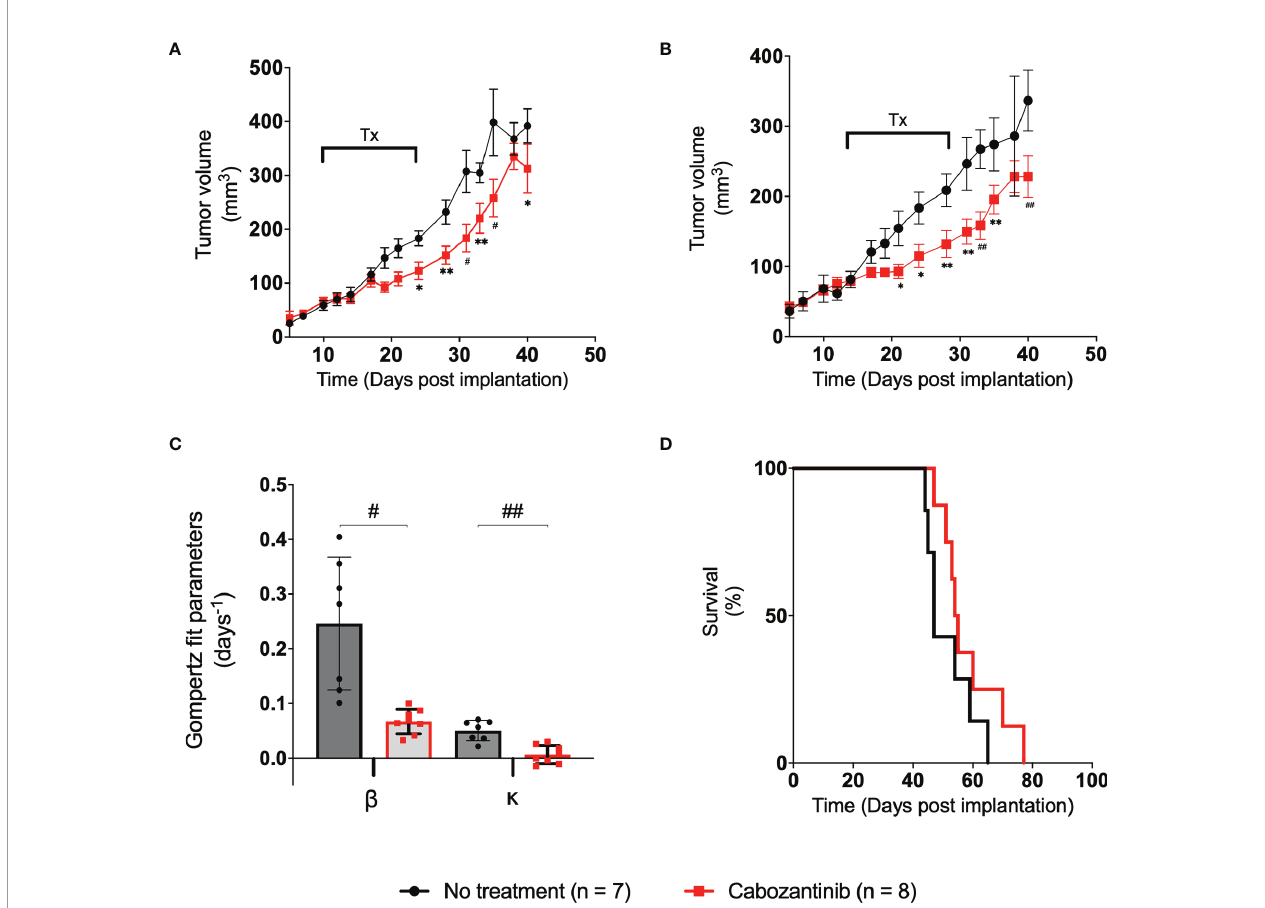
FIGURE 3 | (A) Plot of tumor volume obtained from ultrasound images vs. the time post-tumor implantation. The treatment days are indicated with a bar labeled “ Tx. ” (B) Plot of tumor volume measured with digital calipers vs. days post-tumor implantation. Error bars represent the SEM for each of the groups on a particular day. (C) Bar plot of the spread of each group ’ s Gompertz growth rates. Error bars represent SEM, where n = 8 for each group. (D) Kaplan – Meier survival curve of the two groups over the period of the study. Median survival time for control and treated groups was 47.5 and 54.5 days, respectively. * p < 0.05, ** p < 0.01, # p < 0.001, ## p <